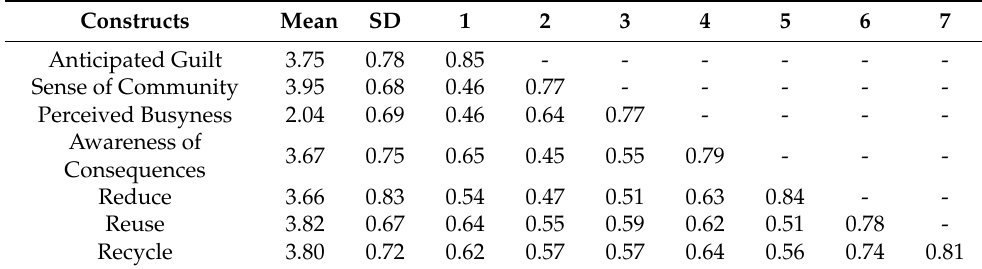
Table 4. Discriminant Validity and Correlation